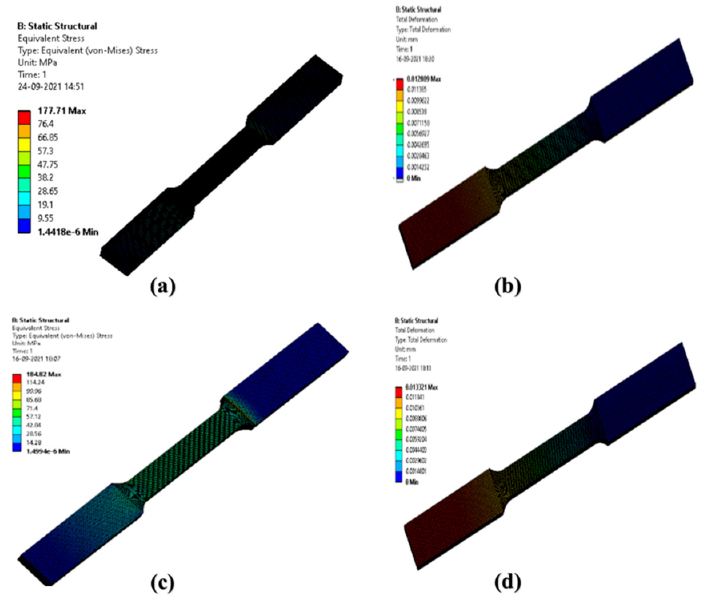
Figure 6. The analysis of the tensile strength of the AZ91D composite reinforced with CF and MWCNT reinforcements. ( a , b ): AZ91D + 0.5% CF’s + 0.5% MWCNT composite and ( c , d ): AZ91D + 0.75% CF’s + 0.75% MWCNT composite.